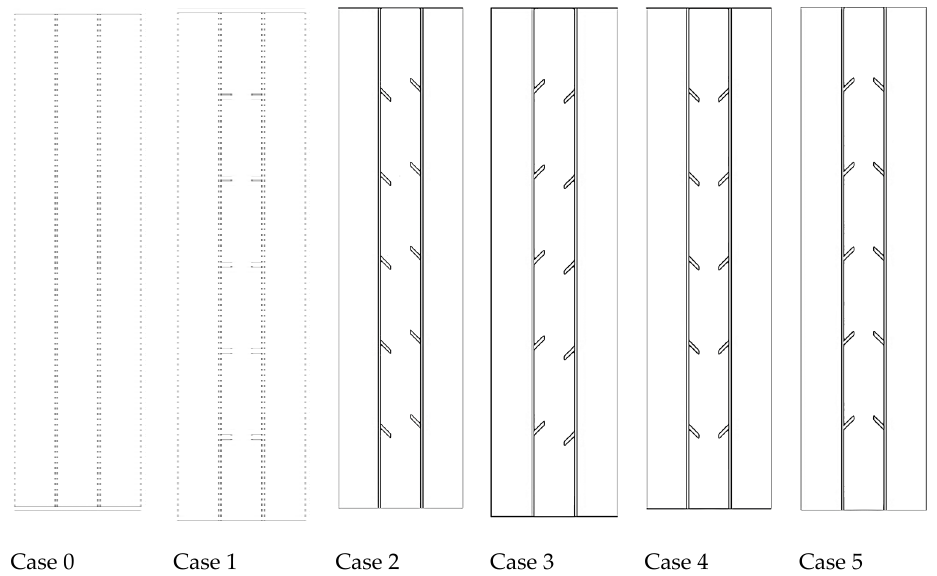
Figure 1. The schematic of different proposed triple-pipe systems in axisymmetric condition; Case 0: no-fin, Case 1: straight fins, Case 2–5: sloped fins with different orientations for the inner and middle tubes